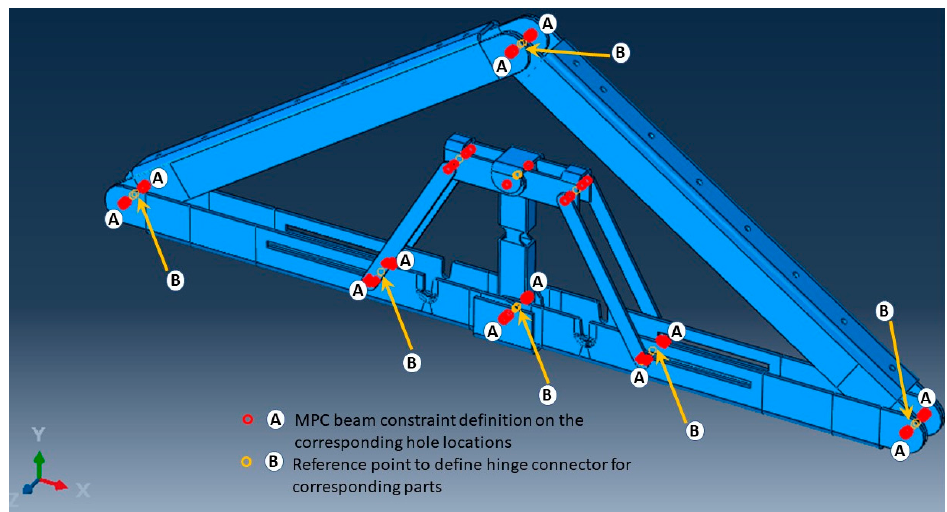
Figure 22. MPC beam constraint location for the hinge connection.